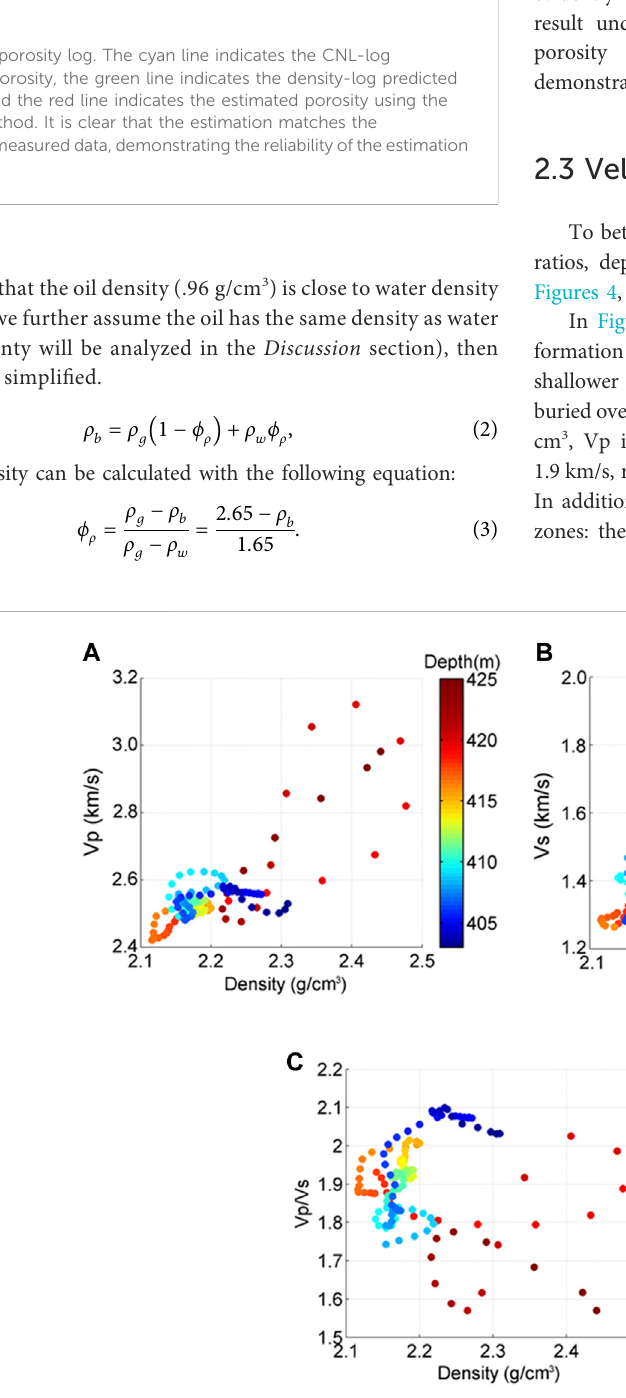
Frontiers in Earth